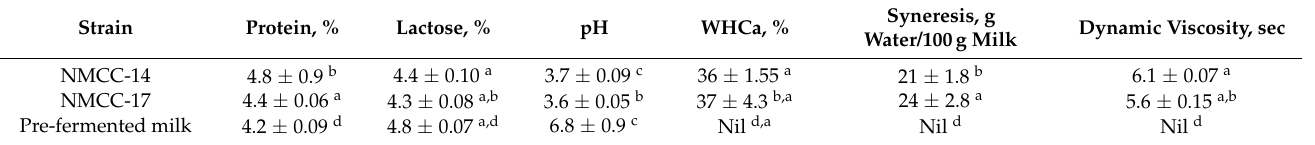
Table 6. Fermentation properties of isolated Lactobacillus fermentum strains in milk.